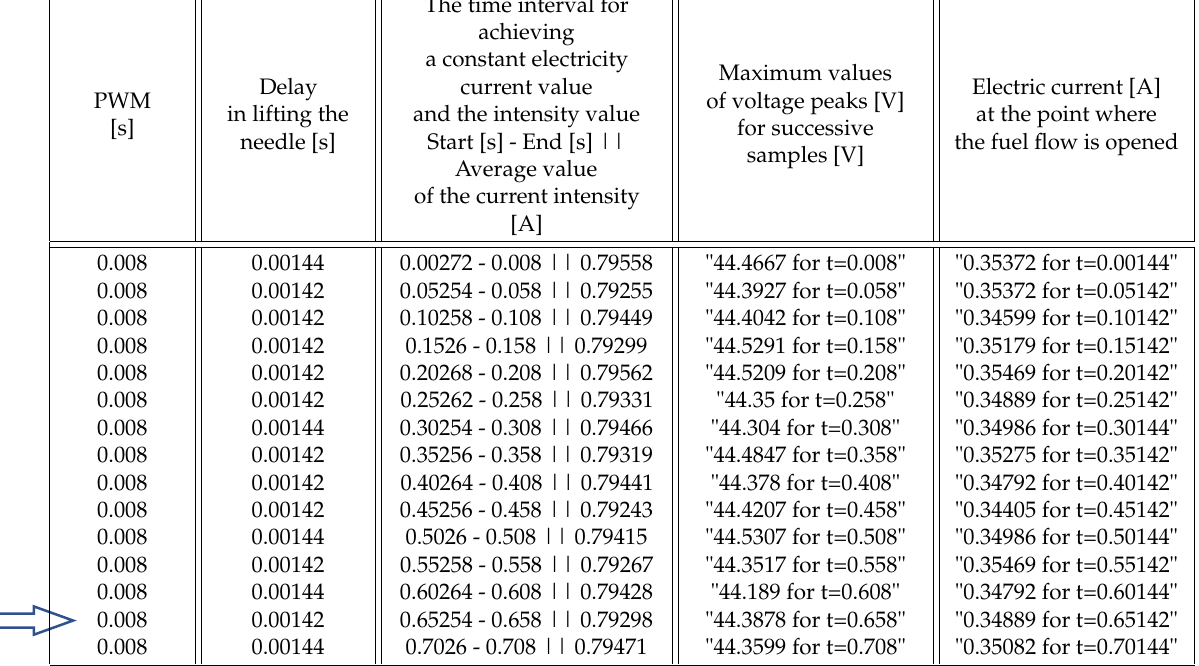
Table 4. User panel filled with selected values—exp. III—8 ms, 0.2 MPa. Table 2. User panel filled with selected values—exp. I—8 ms, 0.4 MPa.